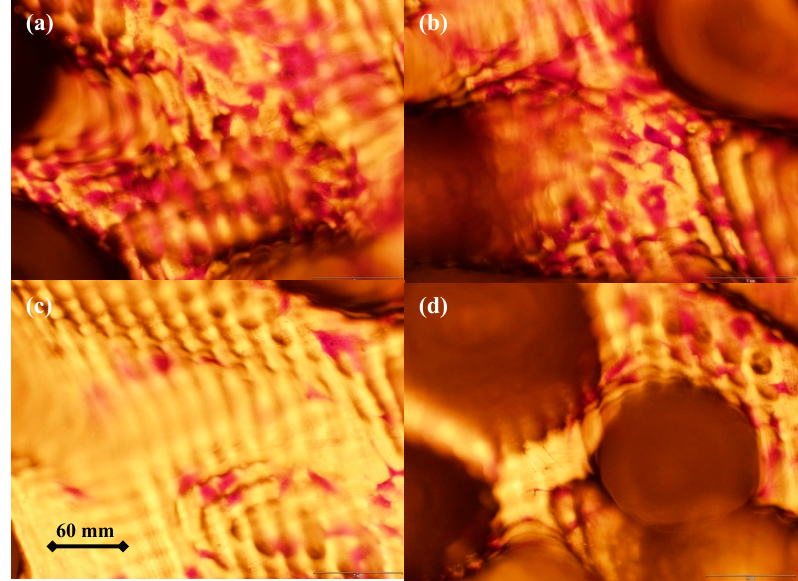
Figure 6. Detailed views of cells on the microsystem for highlighting the impact of hMSC-CM: ( a , b ) Cells cultured on pre-treatment surfaces; ( c , d ) Cells cultured on non-pre-treatment surfaces.